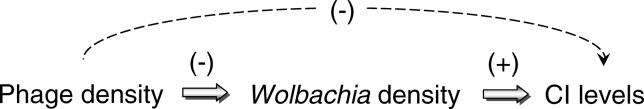
A Phage Density Model of CIThis flowchart depicts the predicted associations, i.e., (−) negative and (+) positive, between phage densities, Wolbachia densities, and CI levels with arrows connecting the associated variables. The flowchart is based on the following hypothesis: if lytic development of temperate phage WO-B leads to bacterial lysis or slowed cell divisions, the relative copy number of phages per bacterium may negatively associate with the relative copy number of Wolbachia per host, which in turn is well established to positively associate with CI levels. Under this scenario, phage densities can have a secondary negative association with CI levels.